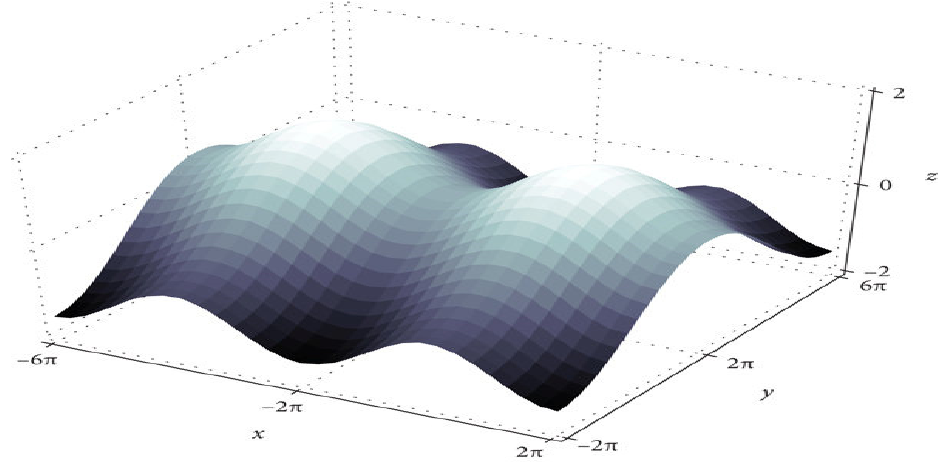
Figure 2. The saddle point in the loss landscape.